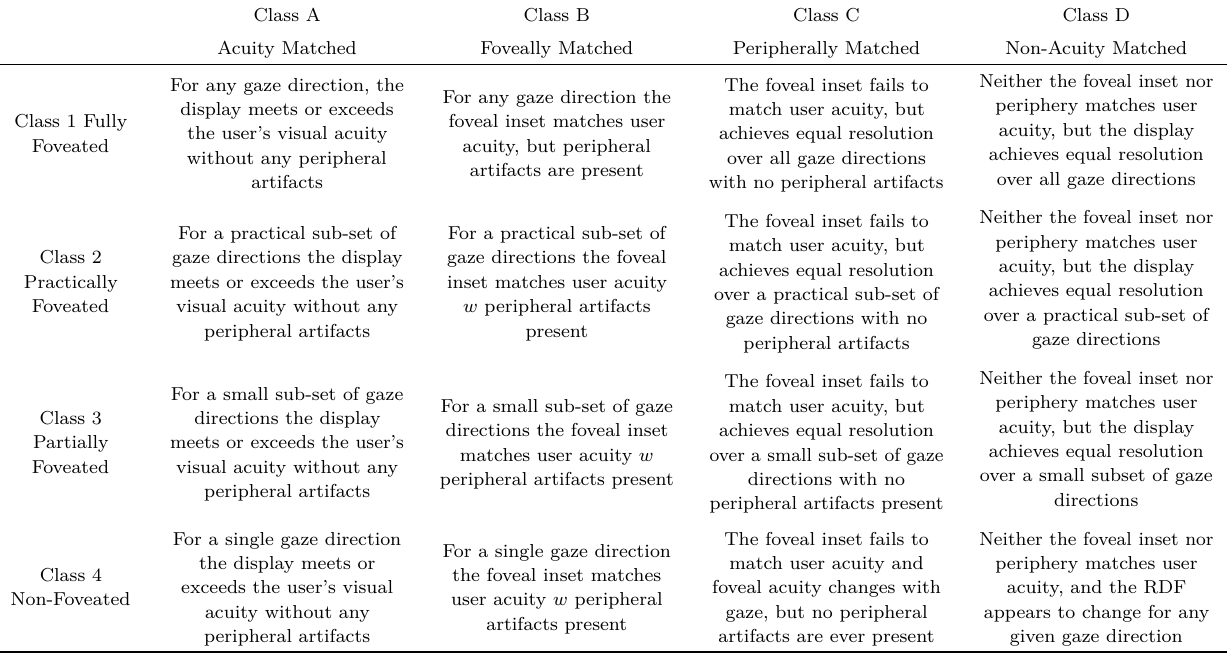
Table 1 The classification matrix is produced by combining RDF classification (letters) with motion classification (numbers) from Spjut et al.